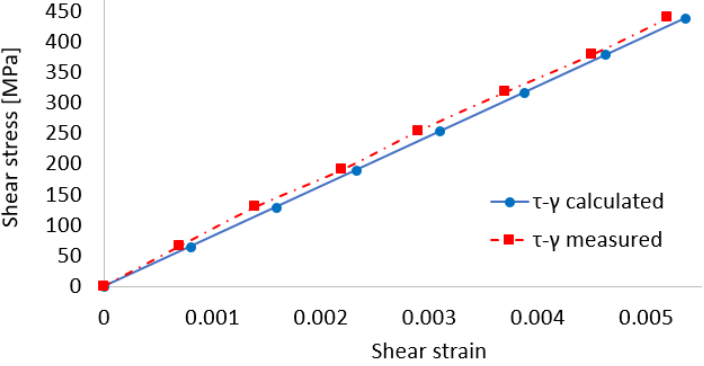
Figure 9. The shear stress versus shear strain variations, calculated and experimentally measured.